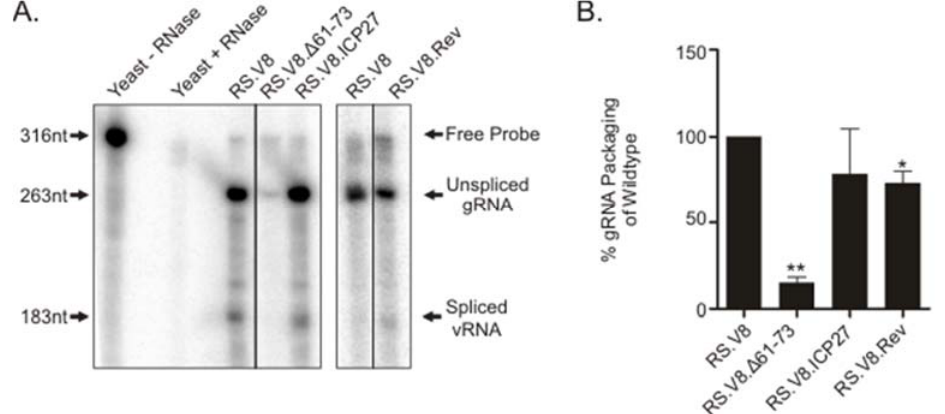
Figure 3. Genomic RNA (gRNA) packaging e ffi ciency of heterologous BR mutants. ( A ) Wild-type RS.V8 or mutant proviral vectors containing the Gag. ∆ 61.73 deletion or substitutions of Gag.ICP27 BR or Gag.Rev BR were transfected into QT6 cells. Virus particles were collected for 48 h and were normalized using reverse transcriptase assay. Equivalent amounts of virus particles were used to extract RNA, and ribonuclease protection assay was used to measure the levels of spliced and unspliced viral RNA present. After hybridization of the 318-nt 32 P-radiolabled antisense riboprobe, which spans the 3 ′‐ splice acceptor site in env , and digestion of the unprotected fragment with RNase treatment, the RNA was separated by gel electrophoresis and visualized using a phosphorimager. Black lines represent lanes that were removed and spaces between the gels represent results from independent experiments. Arrows to the left identify nucleotide lengths, and arrows to the right denote the species of RNA (free probe, unspliced gRNA, and spliced viral RNA). ( B ) The results of four independent experiments are shown on the graph, with the bars representing standard error of the mean. * p ‐ value = 0.0278; ** p ‐ value = 0.0001 when compared to wild ‐ type levels by Student’s t ‐ test.